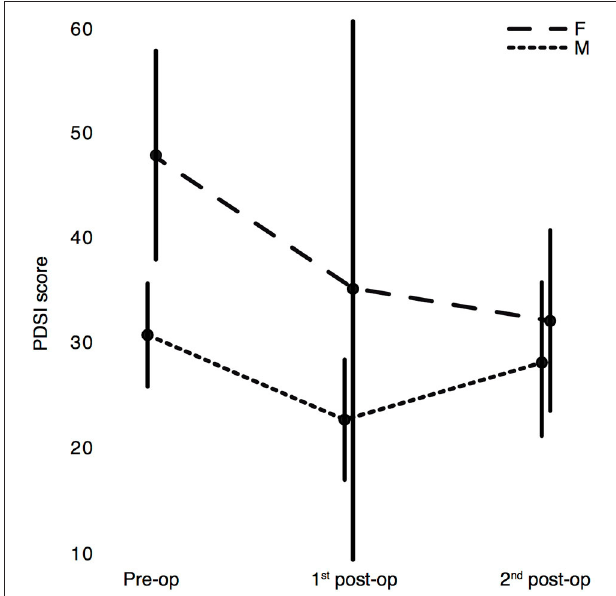
FIGURE 4 | Estimated marginal means of the Parkinson’s Disease Questionnaire (PDQ-39) sum score PDSI with 95% CI. Assessment of PDSI scores in PD patients at the three experimental stages: pre-operation, 1st post-operation, 2nd post-operation separated by sex: F = female, M = male. Higher scores correspond to a worse